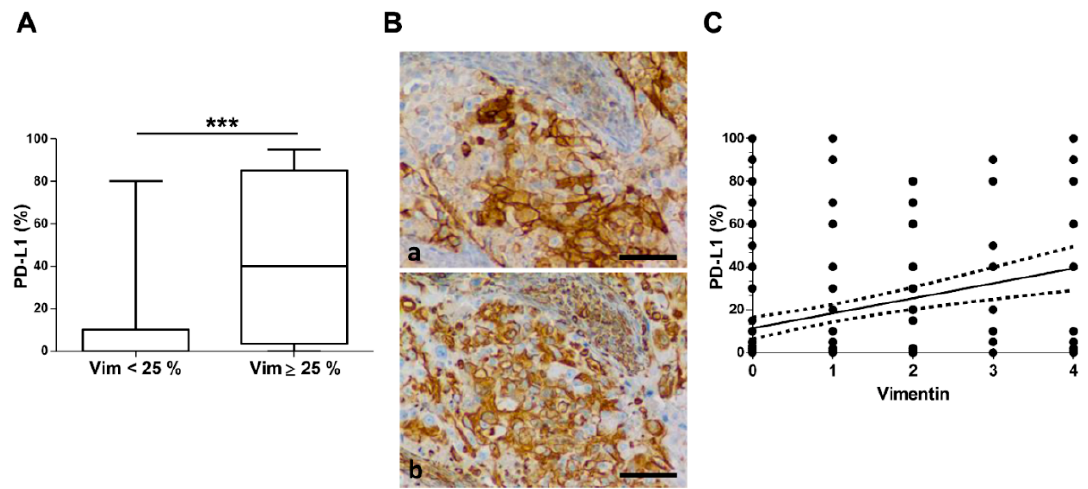
Figure 2. PD–L1 and vimentin association in NSCLC. ( A ) PD–L1 repartition by vimentin expression. High vimentin expression was considered with ≥ 25% ( n = 30) tumor cell immunostained and low for others ( n = 158). Data in the boxplots are presented as median ± 95 percentile. *** p < 0.001. ( B ) PD–L1 and vimentin expression are co-expressed in tumor cells. Histopathological illustration of PD–L1 and vimentin expression on adenocarcinoma (Bar = 60 µm). ( C ) Vimentin expression is correlated with PD–L1 expression in NSCLC. ( r = 0.300; p < 0.0001). Regression line with confidence interval 95 CI